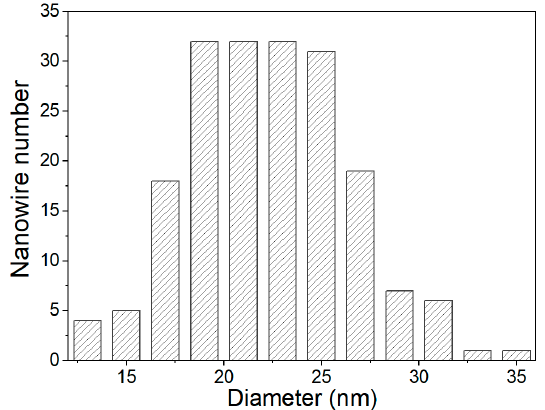
Figure A1. Statistics relative to the diameter of ZnO NWs in nanonet. The total of nanowire measured is 188.